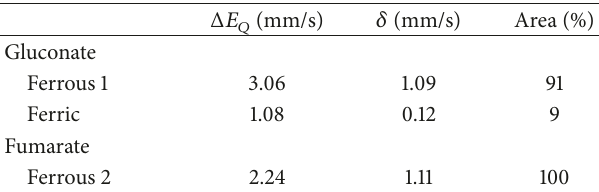
Table1:Theparametersofquadrupolesplitting( Δ𝐸 𝑄 ),isomershifts ( 𝛿 ), and absorption area for ferrous gluconate and ferrous fumarate.